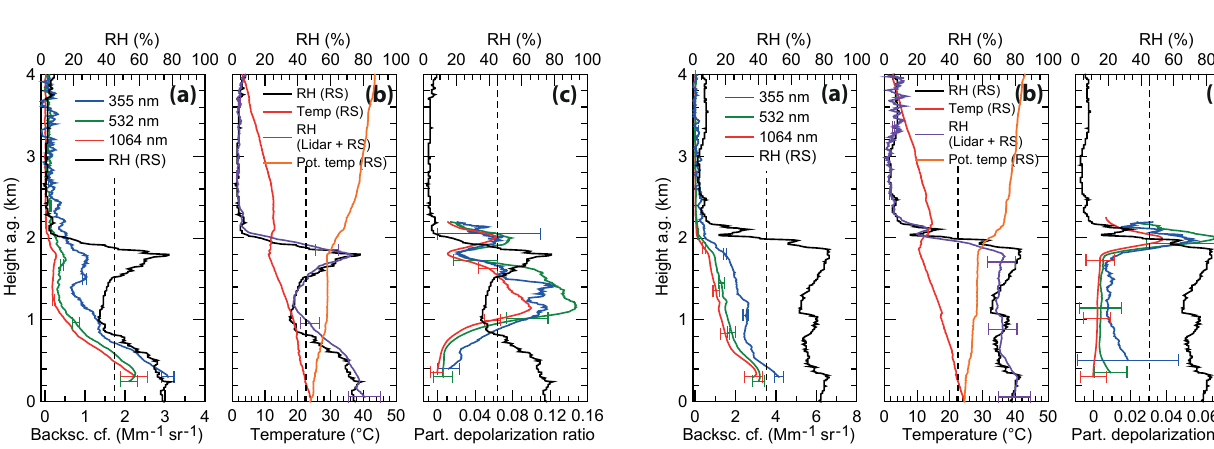
imum of 0.148 ± 0.035 at 532 nm at around 1150 m height.